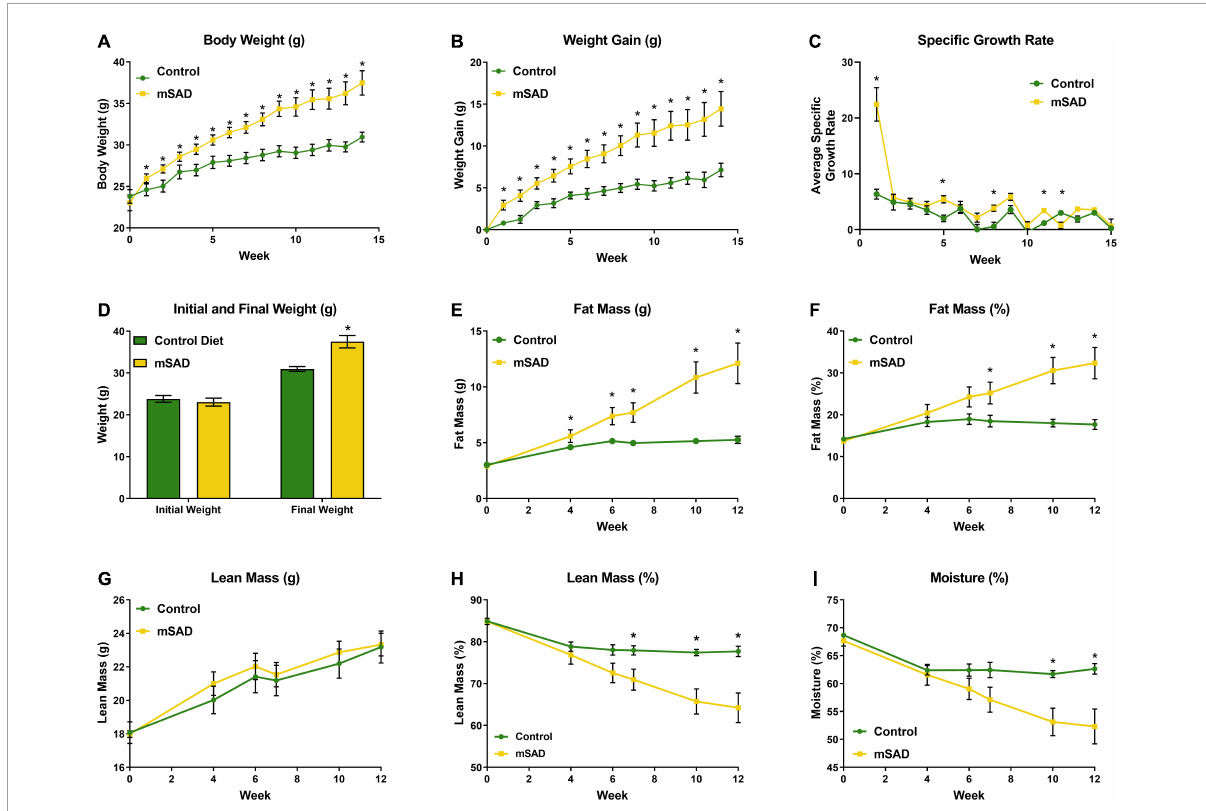
FIGURE1 Effects of diet on weight and body composition. Male C57BL/6J mice were proffered the CON or the mSAD diet for a 15-week period. (A) Body weight was measured weekly ( n = 12/diet). (B) Cumulative weight gain and (C) specific growth rate for each diet. (D) Initial and final weights for each diet. QMR analysis at 4, 6, 7, 10, and 12 weeks ( n = 6/diet) includes (E) g fat mass, (F) % fat mass, (G) g lean mass, (H) % lean mass, and (I) percent water. Values are represented as mean ± SEM. Data were compared using Welch’s t -test. * p <